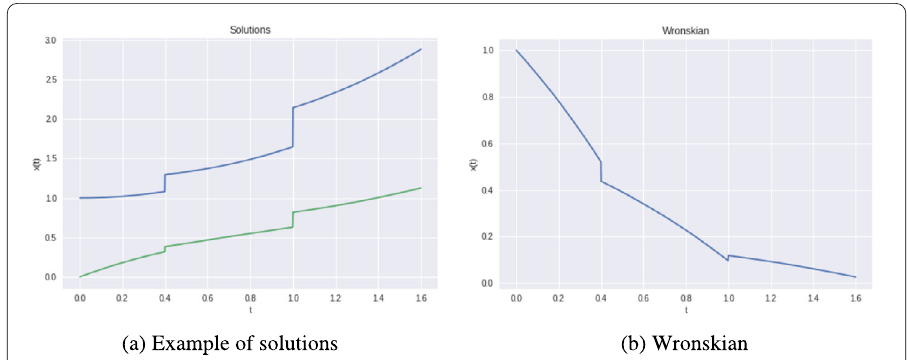
Figure 2 Calculating the Wronskian of the fundamental system of solutions of a homogeneous